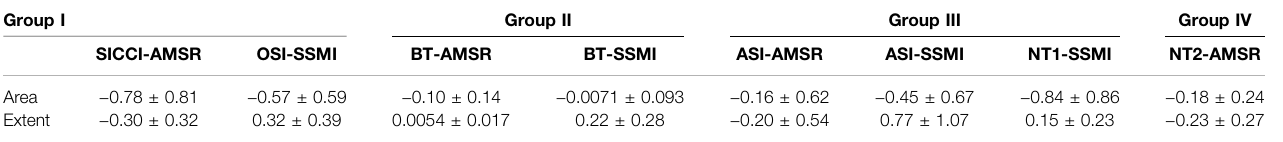
Group I Group II Group